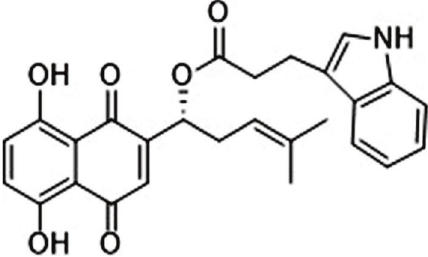
reduction assay. Figure 1. Chemical structure of